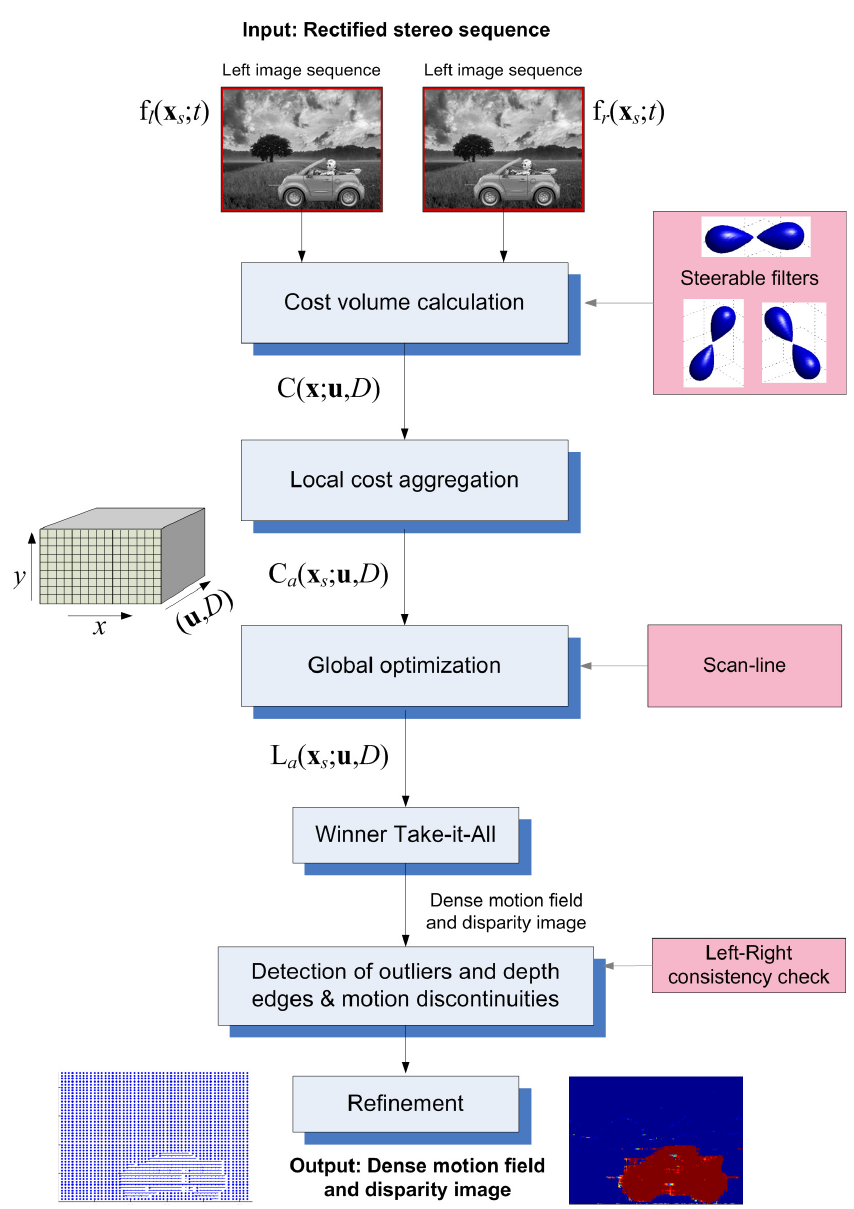
Figure 1. Block diagram, summarizing the main steps of the